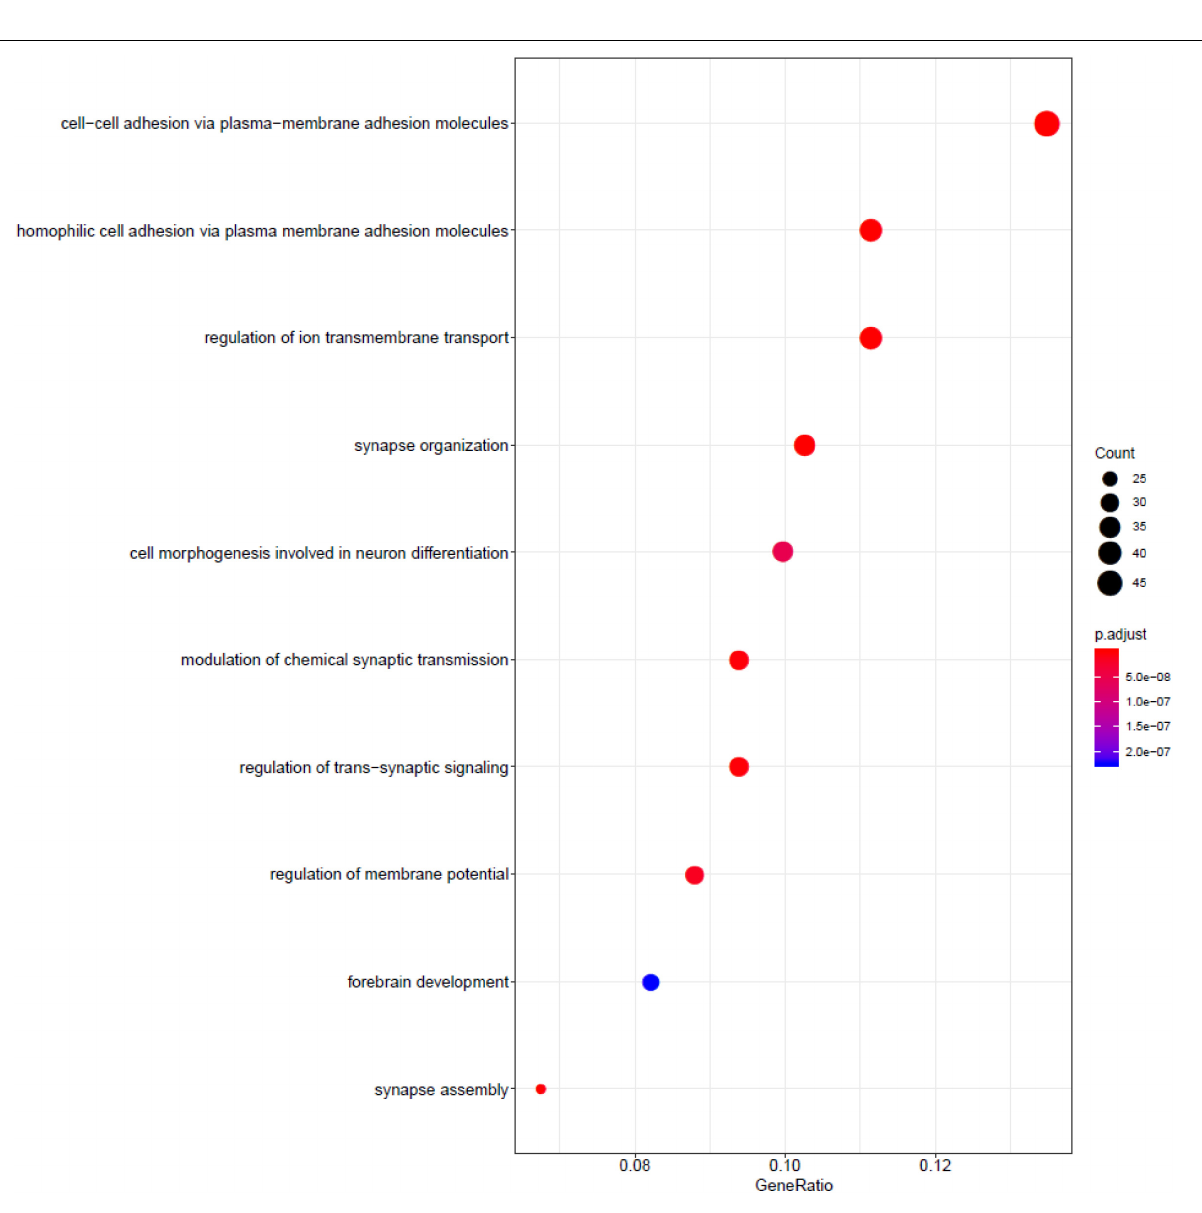
FIGURE 2 | Functional annotation of the top 500